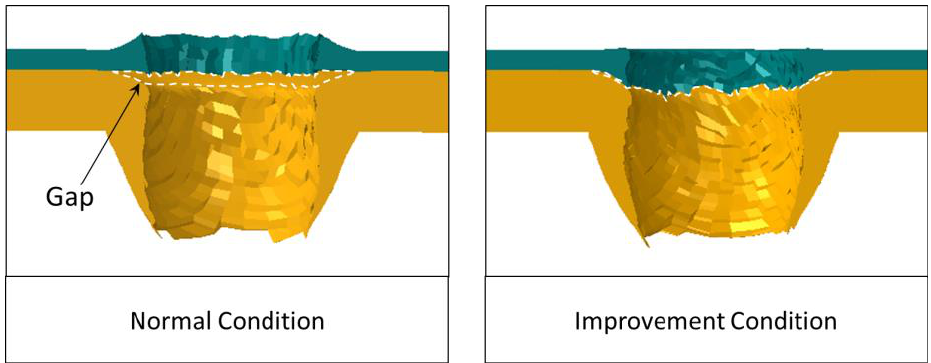
Figure 29. Numerical prediction and comparison between friction-drilled joints under normal and improvement conditions. improvement